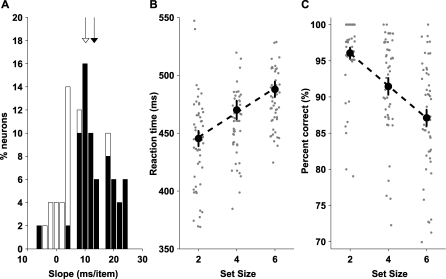
Behavioral Performance(A) Dependence of reaction time on set size in the 50 recording sessions that tested all set sizes. Histogram shows the distribution of slopes representing the dependence of reaction time on set size. Filled bars indicate slopes significantly different from 0. Arrows show the average slope for the entire population (open) and for the significant subset (filled).(B) Dependence of reaction time on set size across the population. Each gray dot is the average reaction time from one session, and the large filled symbols show average and standard error across the sample. The dashed line is the best fit through the data points using Equation 1 (Materials and Methods section).(C) Dependence of accuracy on set size. Each small gray point is the fraction correct in one session (same sessions as in (A) and (B)), and the line shows the best fit to Equation 1 with accuracy as the dependent variable.